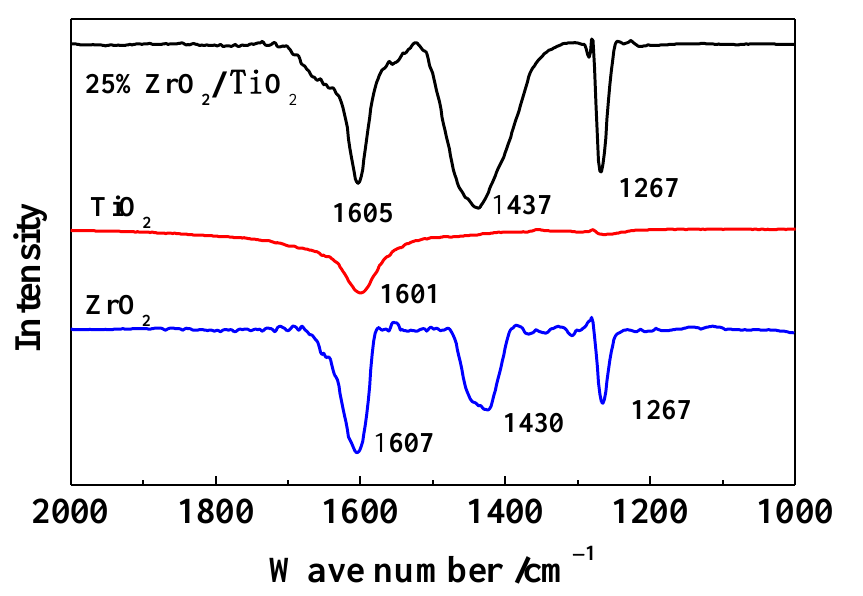
Figure 3. NH 3 -FTIR spectrum of samples. Table 1. Surface area, pore volume, NH 3 adsorption amount and catalytic performance of